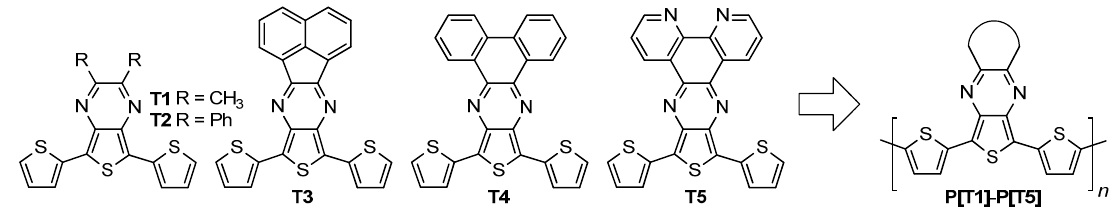
Figure 4. Thieno[3,4- b ]pyrazine-based terthienyls ( T1 – T5 ) characterized in the current study and their corresponding electropolymerized polymeric materials ( P[T1] – P[T5] ).